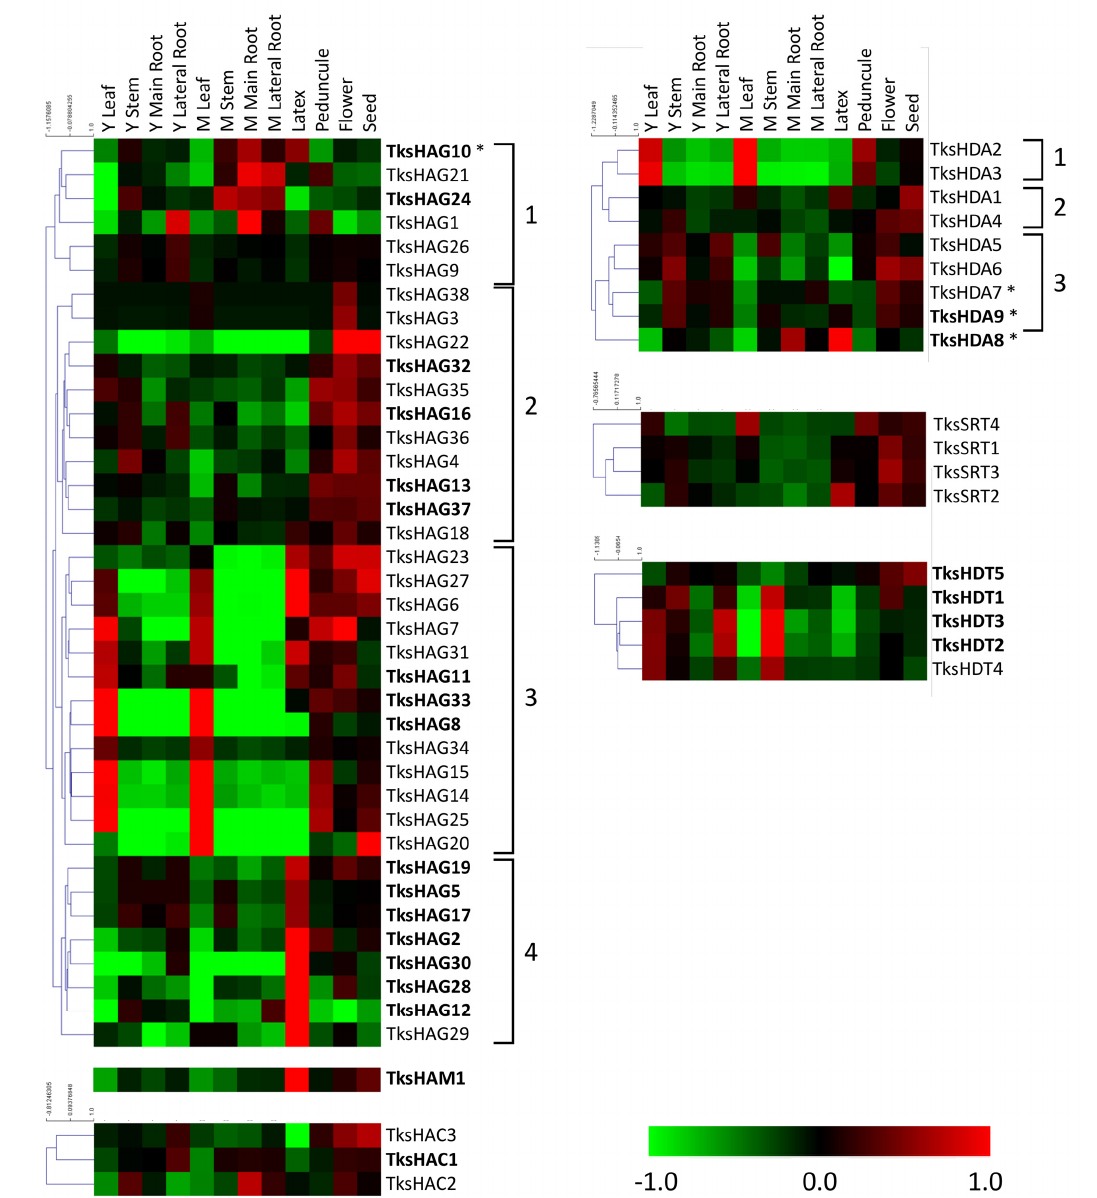
Figure 6. Heat map of Tks HATs and Tks HDACs in different organs and developmental stages. The main clusters are indicated by square brackets. Genes with a higher expression are indicated in bold. Asterisks indicate the genes analysed by qPCR.